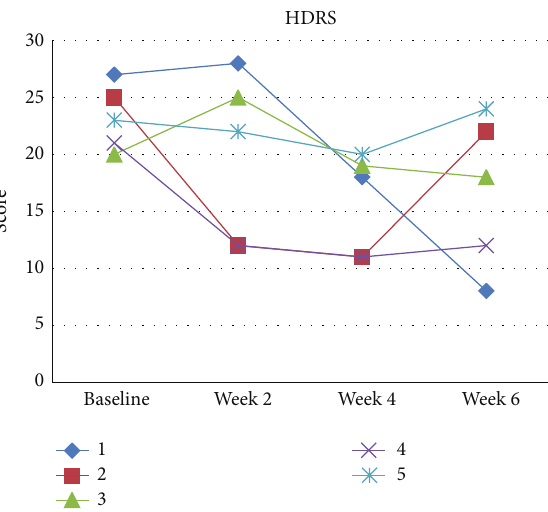
Figure 2: YMRS scores for each patient (pilot phase). Figure 3: HDRS scores for each patient (pilot